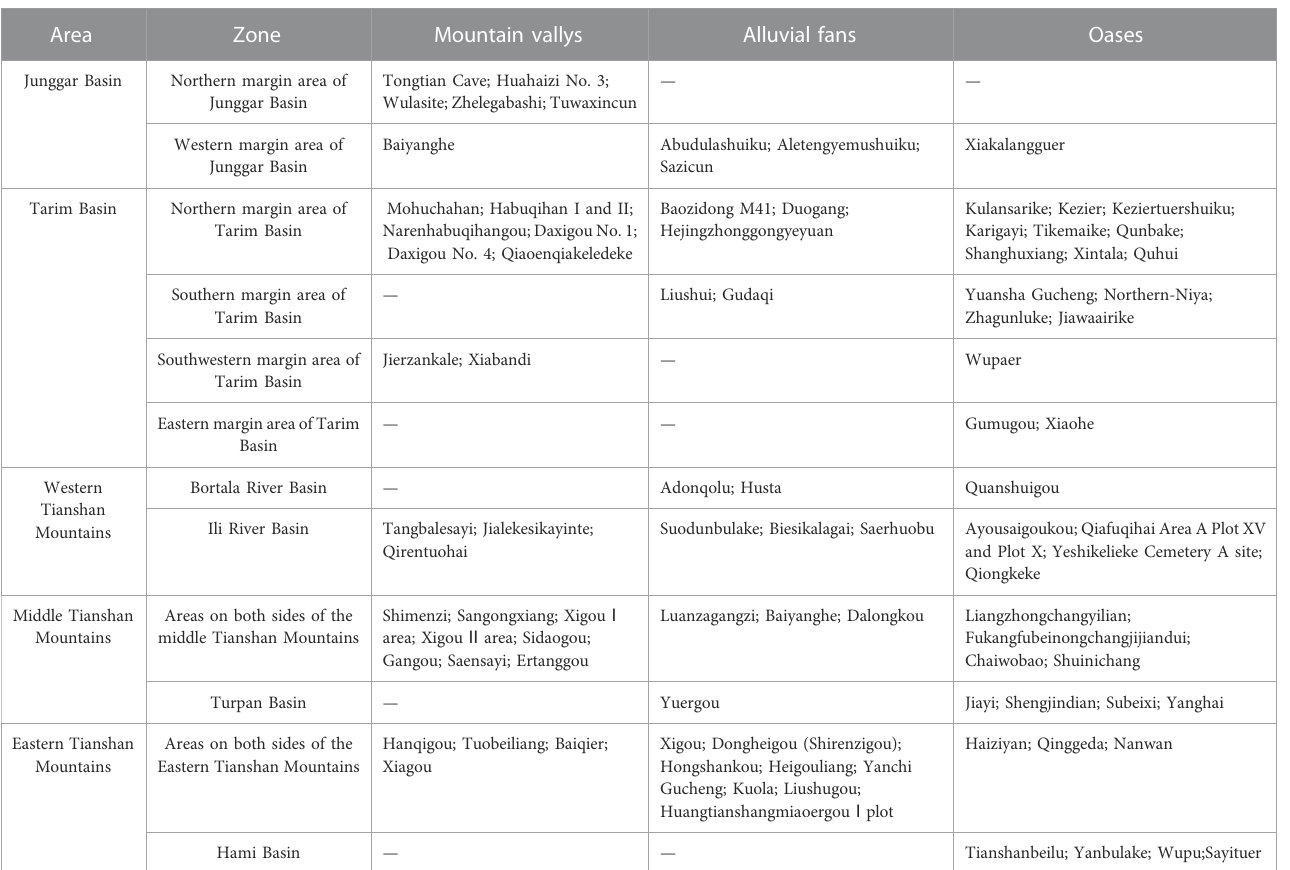
TABLE 1 The geomorphic location of the sites mentioned in this